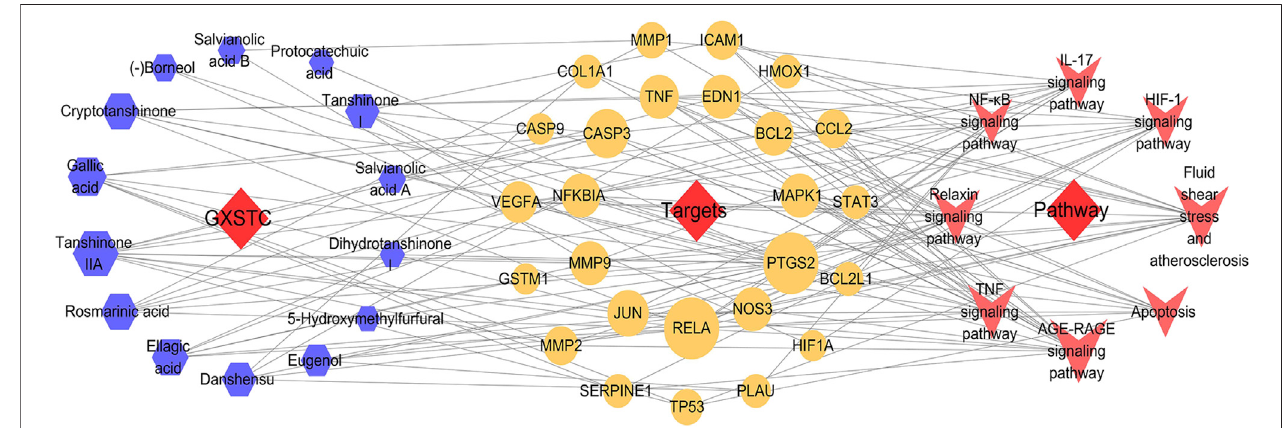
FIGURE6| TheC-T-P networkofGXSTCagainstCBVDs.Thenodes representcomponents(bluehexagons), targets (orangeellipses),and pathways (rose-redV shapes).